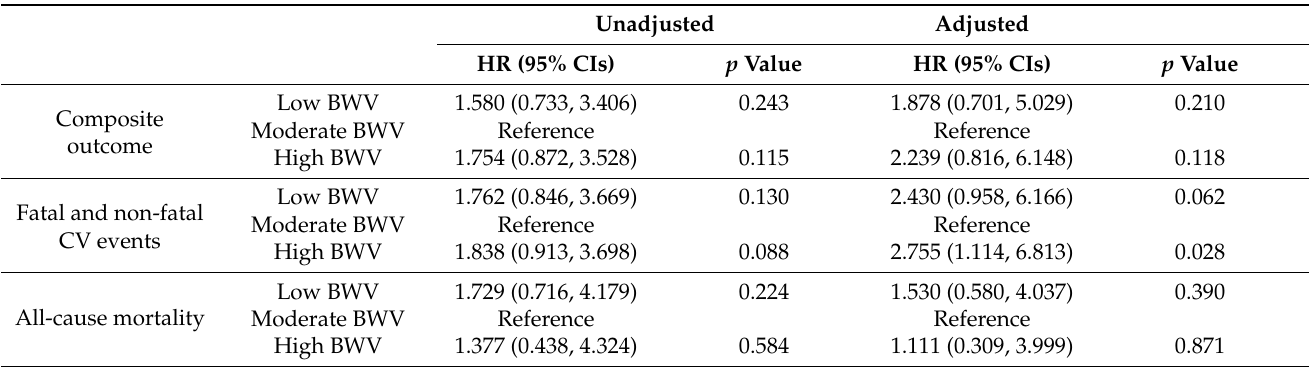
Table 4. Cox proportional hazards regression of BWV for the outcomes in subjects with BW maintenance during follow- up